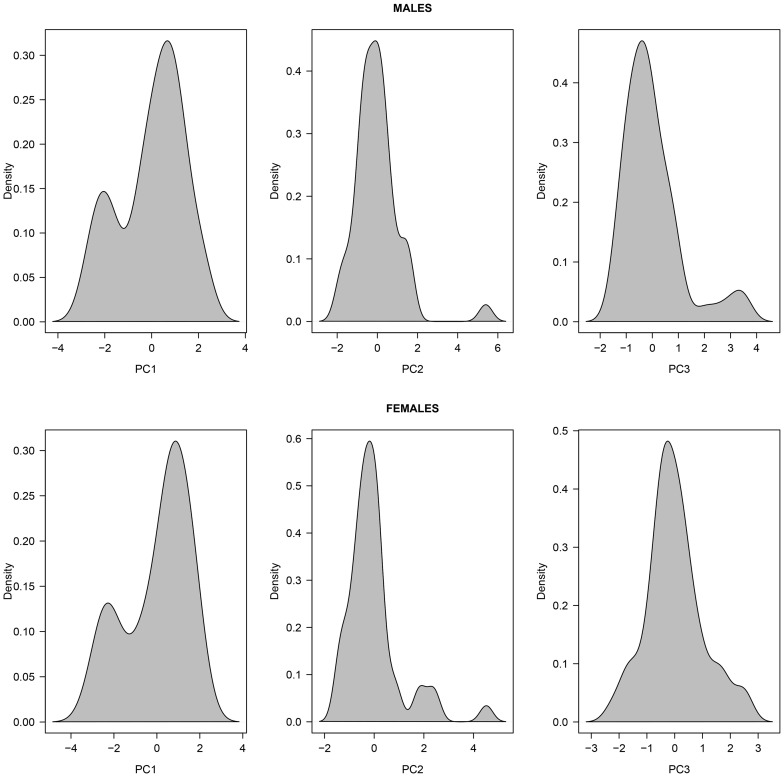
Kernel density distribution of the first three principal components (PC1, PC2, PC3) describing male and female group behavioral time budget in N = 45 different Alpine ibex mating groups.The loadings of the different principal components are given Table 2. Of note, PC1 was bi-normally distributed for both sexes. PC2 and PC3 were normally distributed, apart from a few extreme observations.